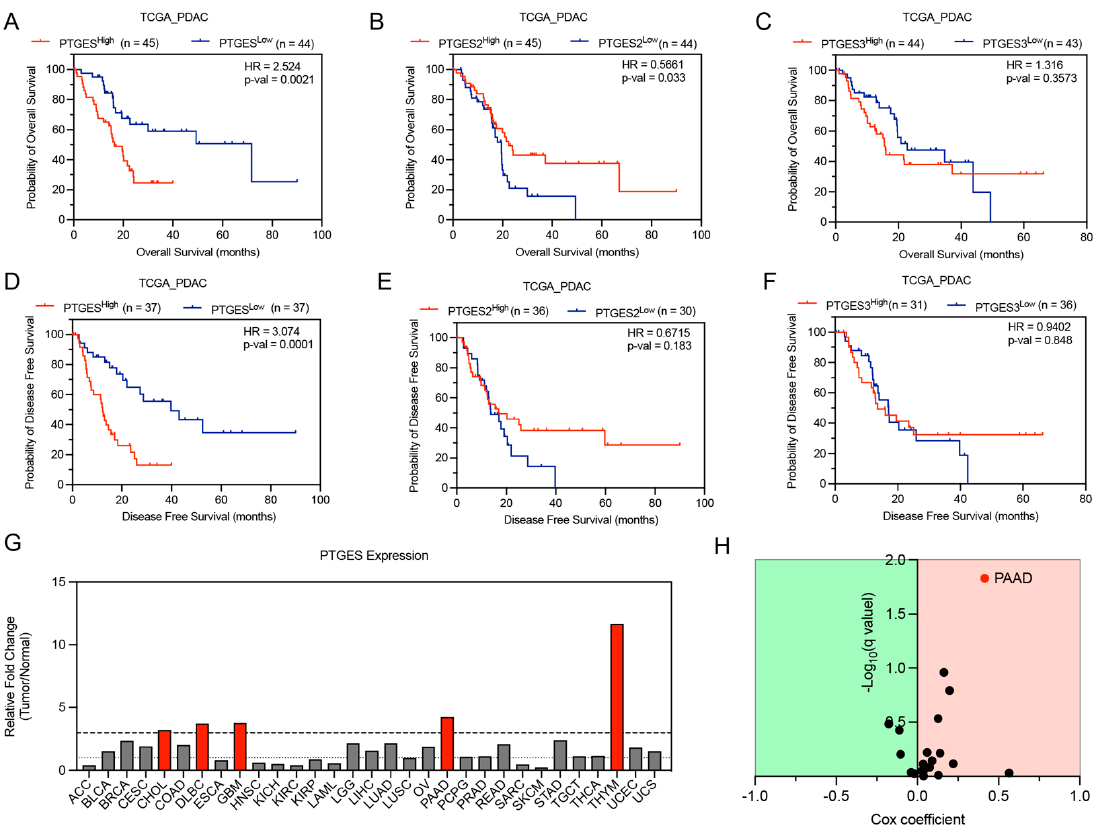
Figure 2. Prostaglandin E synthase-based prediction of pancreatic cancer patient survival. ( A – C ) Kaplan–Meier survival plots showing overall survival of pancreatic cancer patients based on expression of PTGES ( A ), PTGES2 ( B ), and PTGES3 ( C ) mRNA in upper and lower quartiles from the TCGA PAAD patient data. ( D – F ) Kaplan–Meier survival plots showing disease-free survival of pancreatic cancer patients based on quartile expression of PTGES ( D ), PTGES2 ( E ), and PTGES3 ( F ) mRNA from the TCGA PAAD patient data. ( G ) The relative fold change in expression of the PTGES gene in tumor tissues compared to normal tissues in multiple cancers from the TCGA database. The dashed line represents a fold change value of 3. The cancer type with fold change >3 is highlighted in red. ( H ) Volcano plot showing the significant oncogenic function of PTGES in PAAD cancer (red dot) compared to other cancers from the TCGA database. The Cox coefficient of PTGES survival is plotted with the q-value significance.